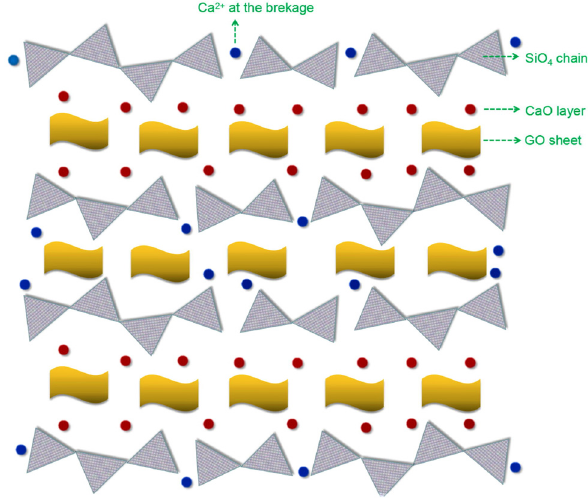
Figure 6: Schematic diagram of the mechanism of GO regulating C – S – H proposed by Zhao et al . [ 75 ] .